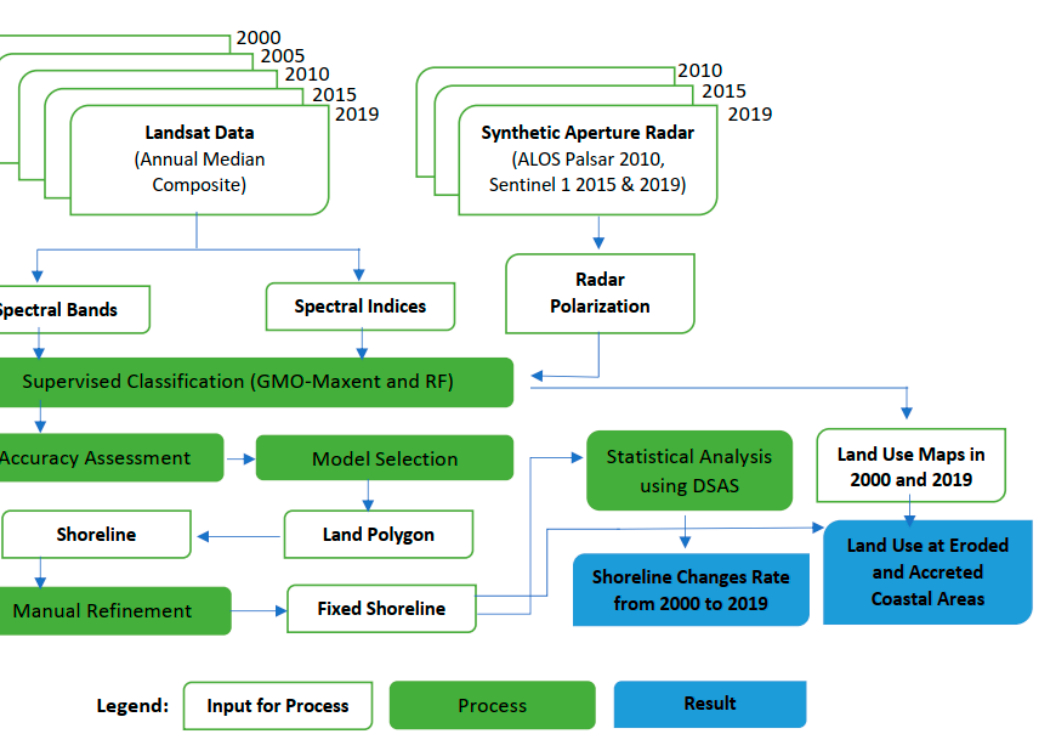
Figure 3. Study methodology flowchart.